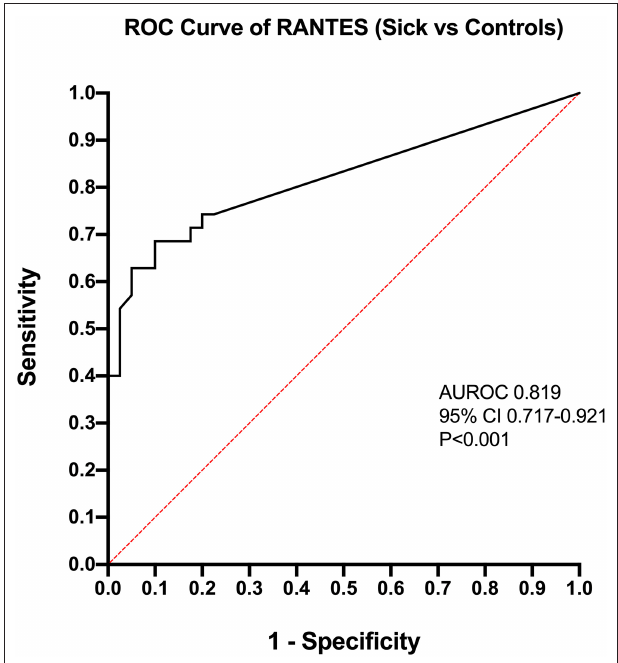
FIGURE 3 | Receiver operating characteristic (ROC) curve for the differentiation of cats with sepsis (sepsis and septic shock) from healthy controls by measurement of Regulated upon Activation, Normal T cell Expressed, and Secreted (RANTES). AUROC, area under the ROC curve; CI, confidence interval.